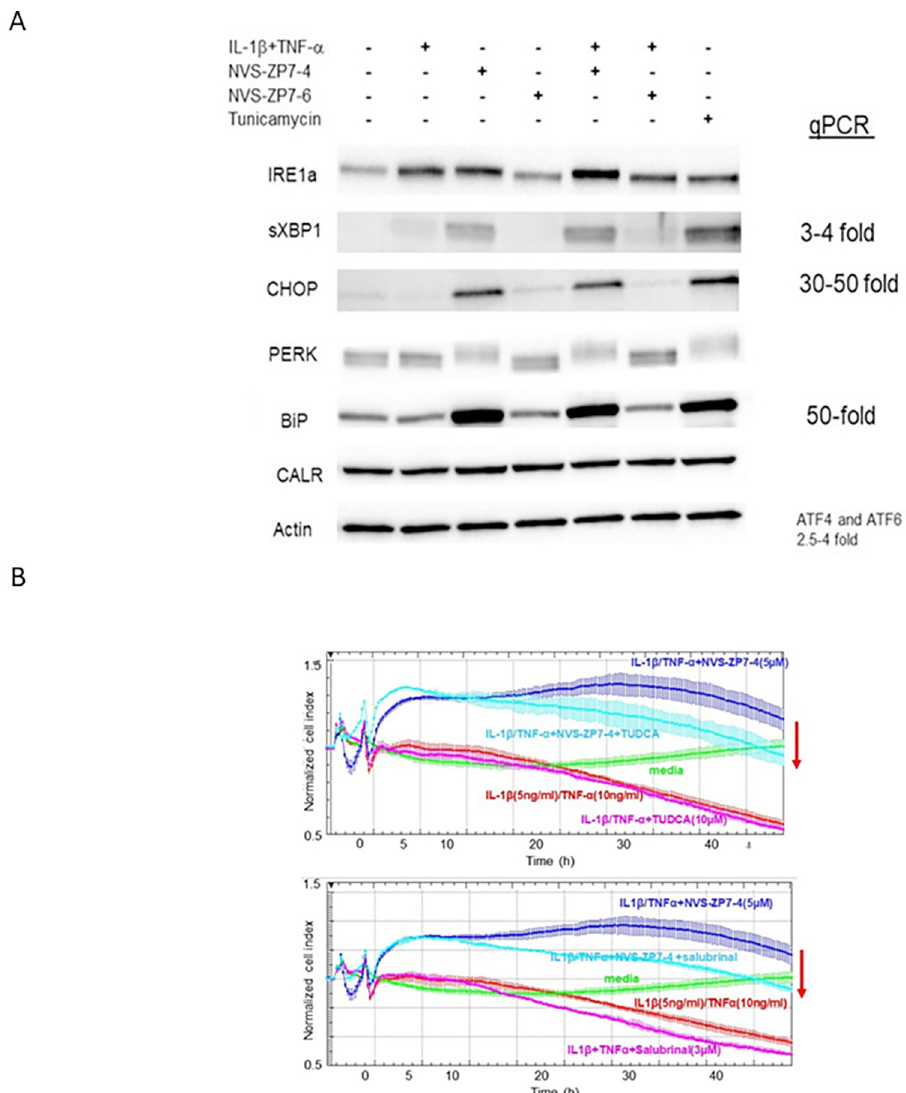
Fig 5. ER stress contributes to barrier protection caused by Zip7 inhibition. A: Cells were challenged with IL-1 β (10ng/mL)/TNF- α (20 ng/mL) in the presence or absence of NVS-ZP7-4 and NVS-ZP7-6 and tunicamycin was used as a positive control. 48h after challenge, cells were harvested for western blot analysis. NVS-ZP7-4 and tunicamycin both induced ER stress resulting in increased levels of sXBP-1, CHOP, BiP and a form of PERK with reduced gel mobility. B: Cells were challenged with IL-1 β (10ng/mL)/TNF- α (20 ng/mL) in the absence and presence of NVS-ZP7-4 and either 10 μ M TUDCA (upper) or 3 μ M salubrinal (lower). Zip7 inhibition with NVS-ZP7-4 prevented impedance loss induced by IL-1 β /TNF- α but inclusion of TUDCA or salubrinal with NVS-ZP7-4 during the challenge reduced impedance.